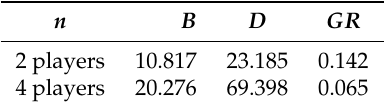
Table 8. Measures of game refinement for two variants of